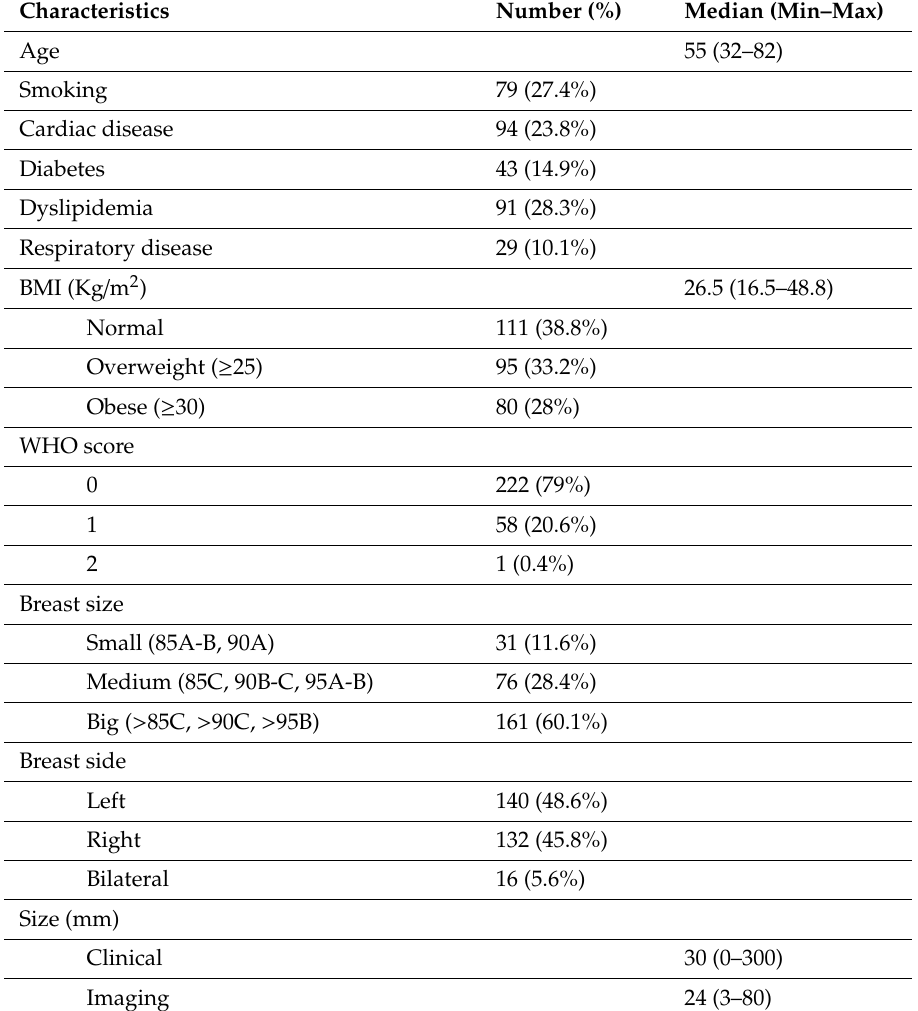
Table 1. Patient